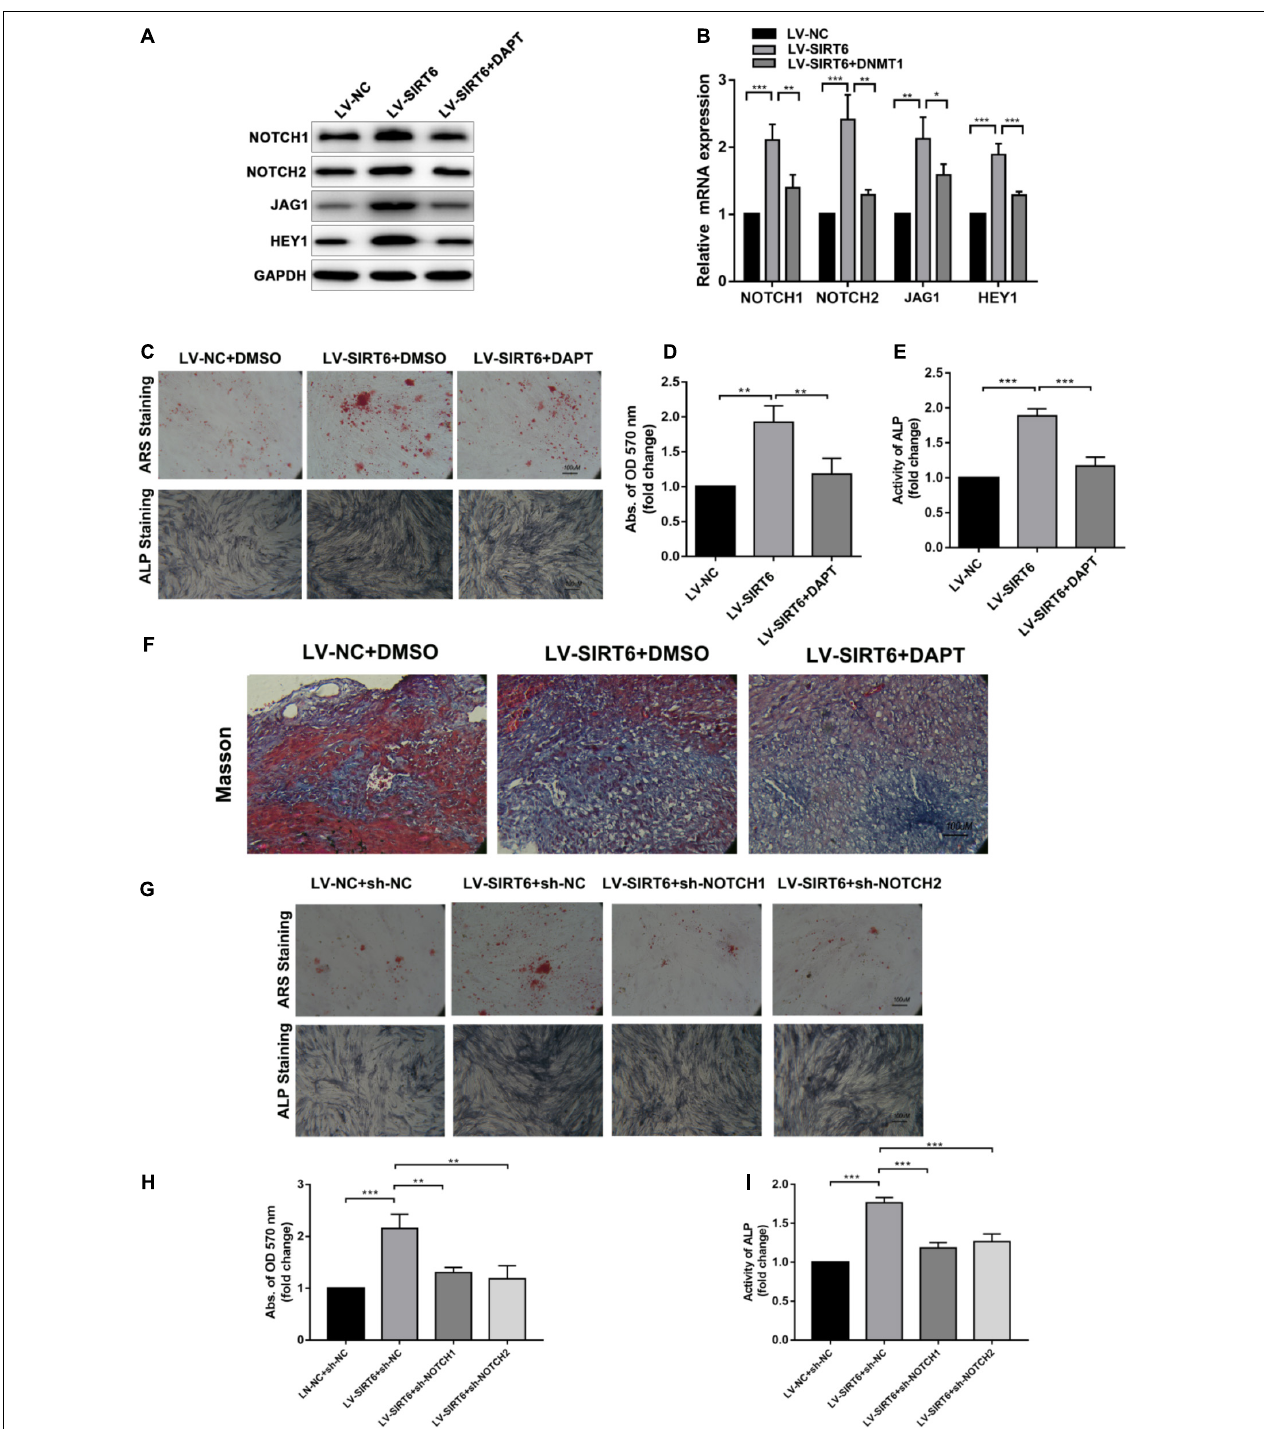
FIGURE 3 | (A,B) SIRT6 overexpressed hADSCs were administered with DAPT, expression of NOTCH1, NOTCH2, JAG1, HEY1 were determined by Western blot and RT-qPCR. (C–E) SIRT6 overexpressed hADSCs were administered with DAPT and osteogenic differentiation medium for 14 days, Alizarin red staining and ALP staining showed mineralized nodule formation. ALP activity and quantification of Alizarin red staining by spectrophotometry were determined. (F) SIRT6 overexpressed hADSCs loaded on HA-TCP were transplanted into the dorsal region of nude mice, the mice were intraperitoneal injected with DAPT for 4 weeks. Then, the removed samples were measured by Masson’s trichrome staining. (G–I) SIRT6 overexpressed hADSCs were transfected with NOTCH1 or NOTCH2 shRNAs and cultured in osteogenic differentiation medium for 14 days, Alizarin red staining and ALP staining showed mineralized nodule formation. ALP activity and quantification of Alizarin red staining by spectrophotometry were determined. Data are shown as means ± SD. * p < 0.05, ** p < 0.01, *** p < 0.001.